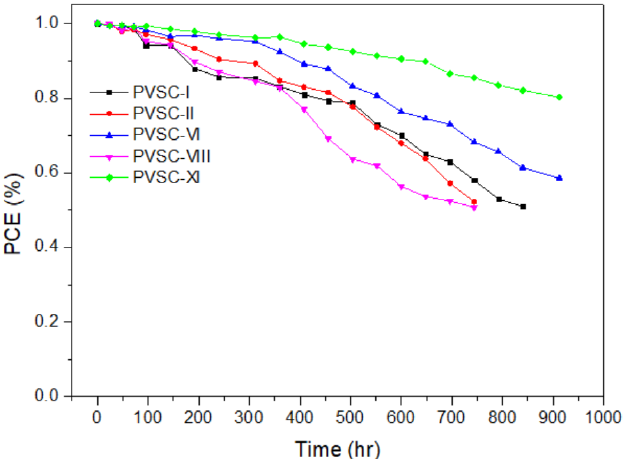
Figure 16. Storage-stability of PVSCs fabricated from the cellulose derivatives modified NiO X HTL (measured at 30 °C and 60% relative humidity).